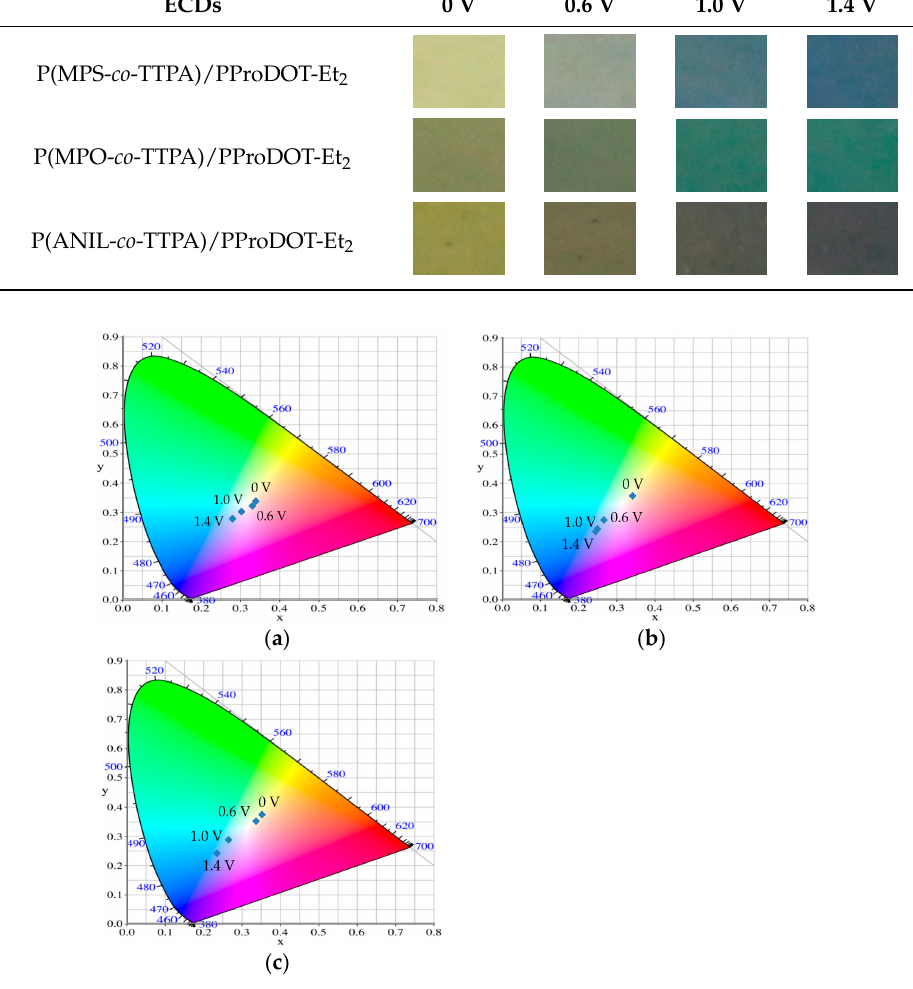
Figure 8. Spectroelectrochemical spectra of ( a ) P(MPS- co -TTPA)/PProDOT-Et 2 ; ( b ) P(MPO- co -TTPA)/ PProDOT-Et 2 ; and ( c ) P(ANIL- co -TTPA)/PProDOT-Et 2 electrochromic devices (ECDs). Table 5. Electrochromic behaviors of ECDs at various voltages.